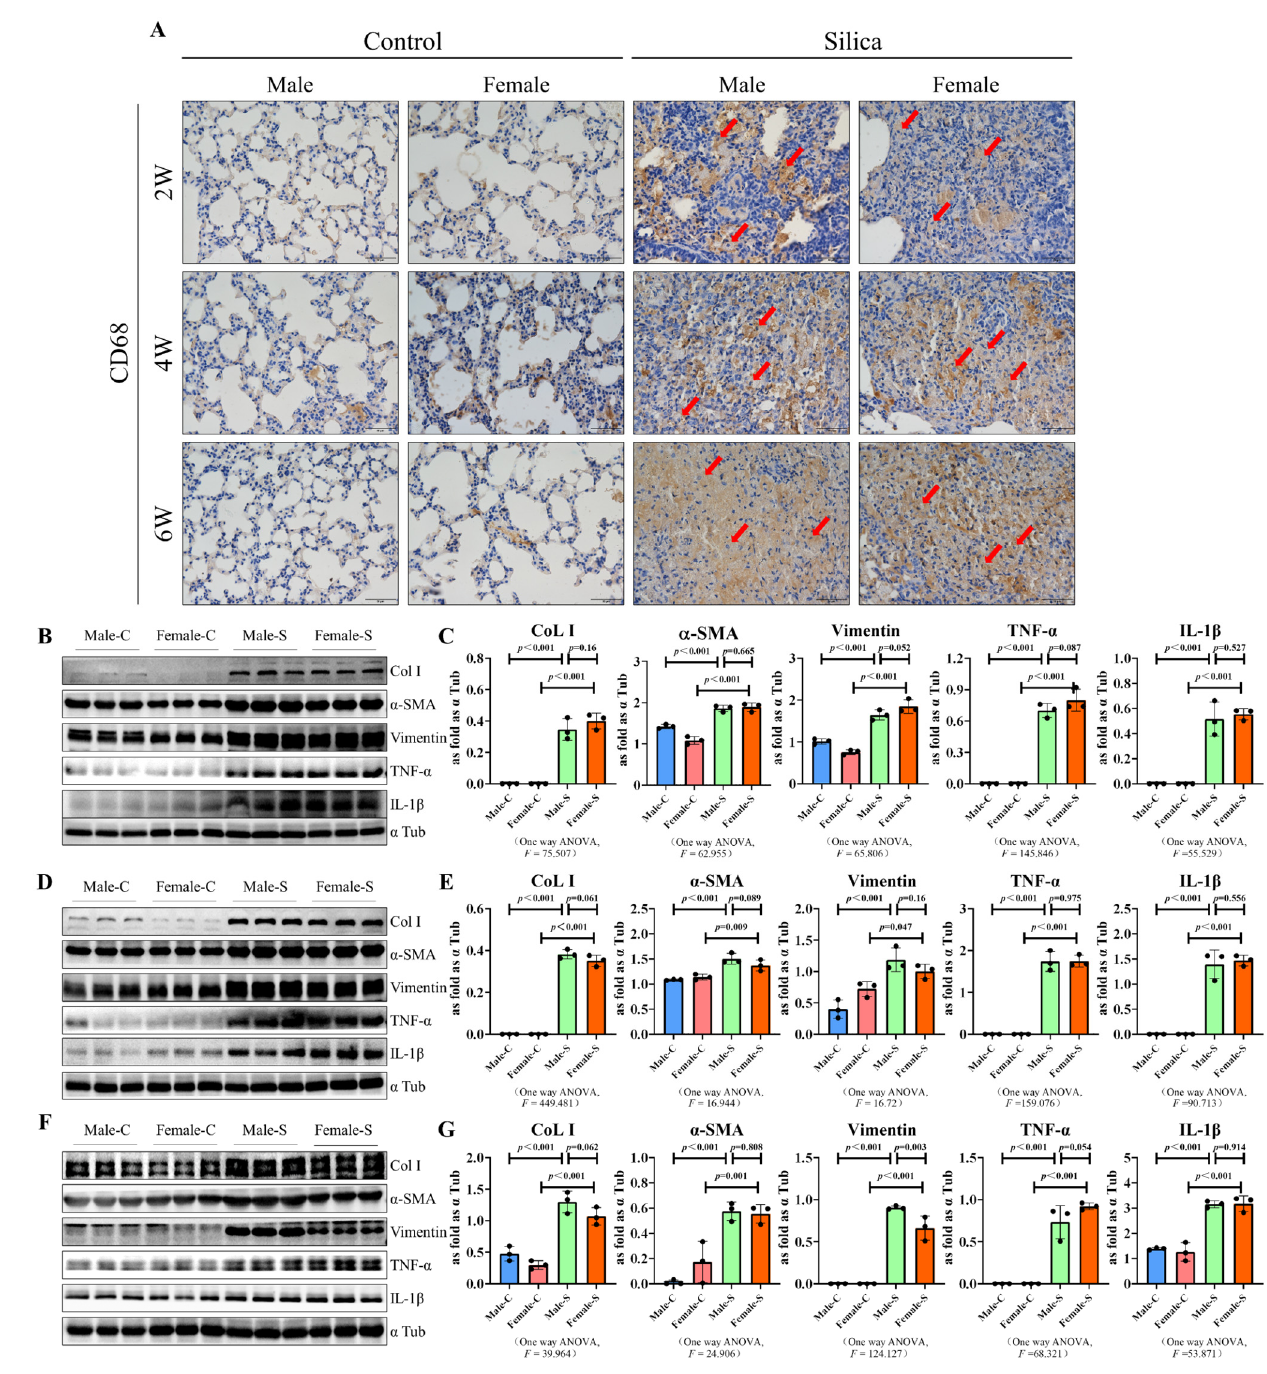
Figure 4. Western blot of CD68, COL I, vimentin, and α -SMA in male and female mice exposed to silica for two, four, six weeks, and the control groups. ( A ) Immunohistochemical staining was used to detect the expression of CD68 in the mouse lung tissues, arrow: CD68-positive cells (brown) (scale bar = 50 µm). ( B – G ) Expression levels of Col I, α -SMA, vimentin, IL 6 and IL 1 β in the lungs of mice were measured using the western blot. Data are presented as the mean ± SD, n = 5 per group (( B , C )—2W, ( D , E )—4W, ( F , G )—6W).